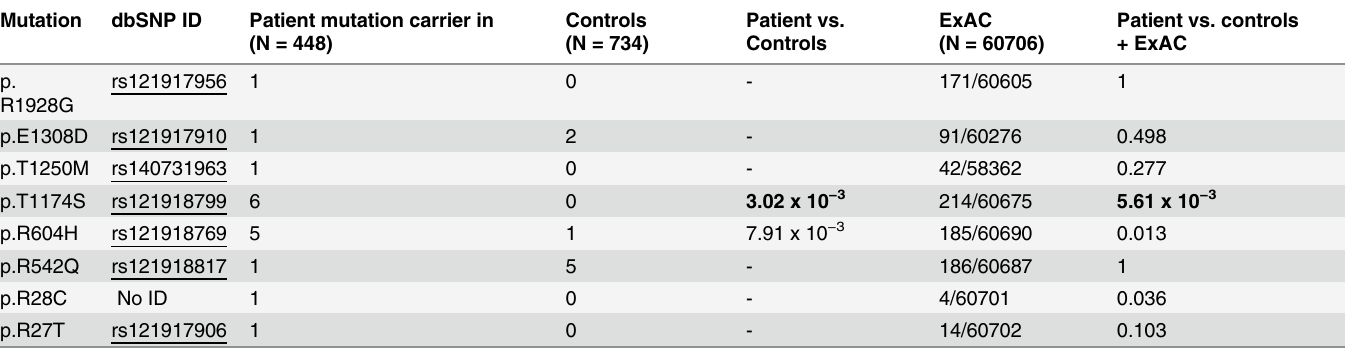
Table 1. HGMD SCN1A mutation frequencies in patients and